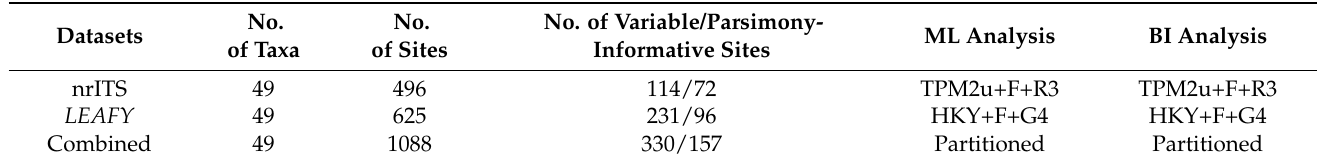
Table 3. Characteristics of separate and concatenated sequence datasets and the model selected for ML/BI